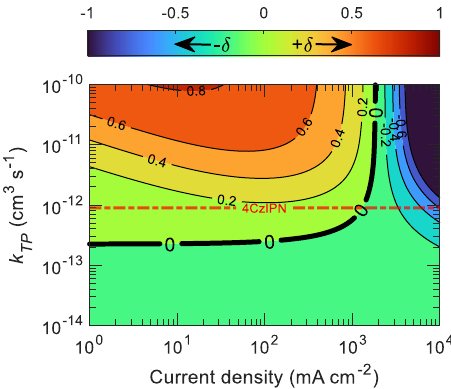
Fig. 5 Disentangling the impact of TPA and SPA. δ versus current density, as a function of k TP values for mCP:4CzIPN OLEDs. In the plot, dominating loss mechanism to singlet density via SPA (negative regions) or indirectly TPA (positive regions). The line ‘ 0 ’ represents the contour where the loss due to SPA and TPA individually, results in the same singlet density. The dash-dot straight line represents experimentally obtained k TP as 9.1 × 10 − 13 cm 3 s − 1 for 4CzIPN